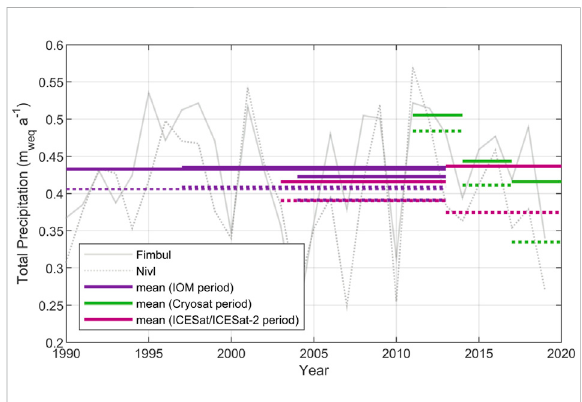
FIGURE 7 AnnualprecipitationreanalysisdatafromERA5averagedover Fimbul and Nivl regions (Hersbach et al., 2020). Solid and dotted gray curves show annual precipitation for Fimbul and Nivl regions, respectively. The data are averaged temporally for different time periods used for IOM, CryoSat-2 and ICESat/ICEsat- 2 geodetic mass balance estimates, solid lines for Fimbul and dashed lines for